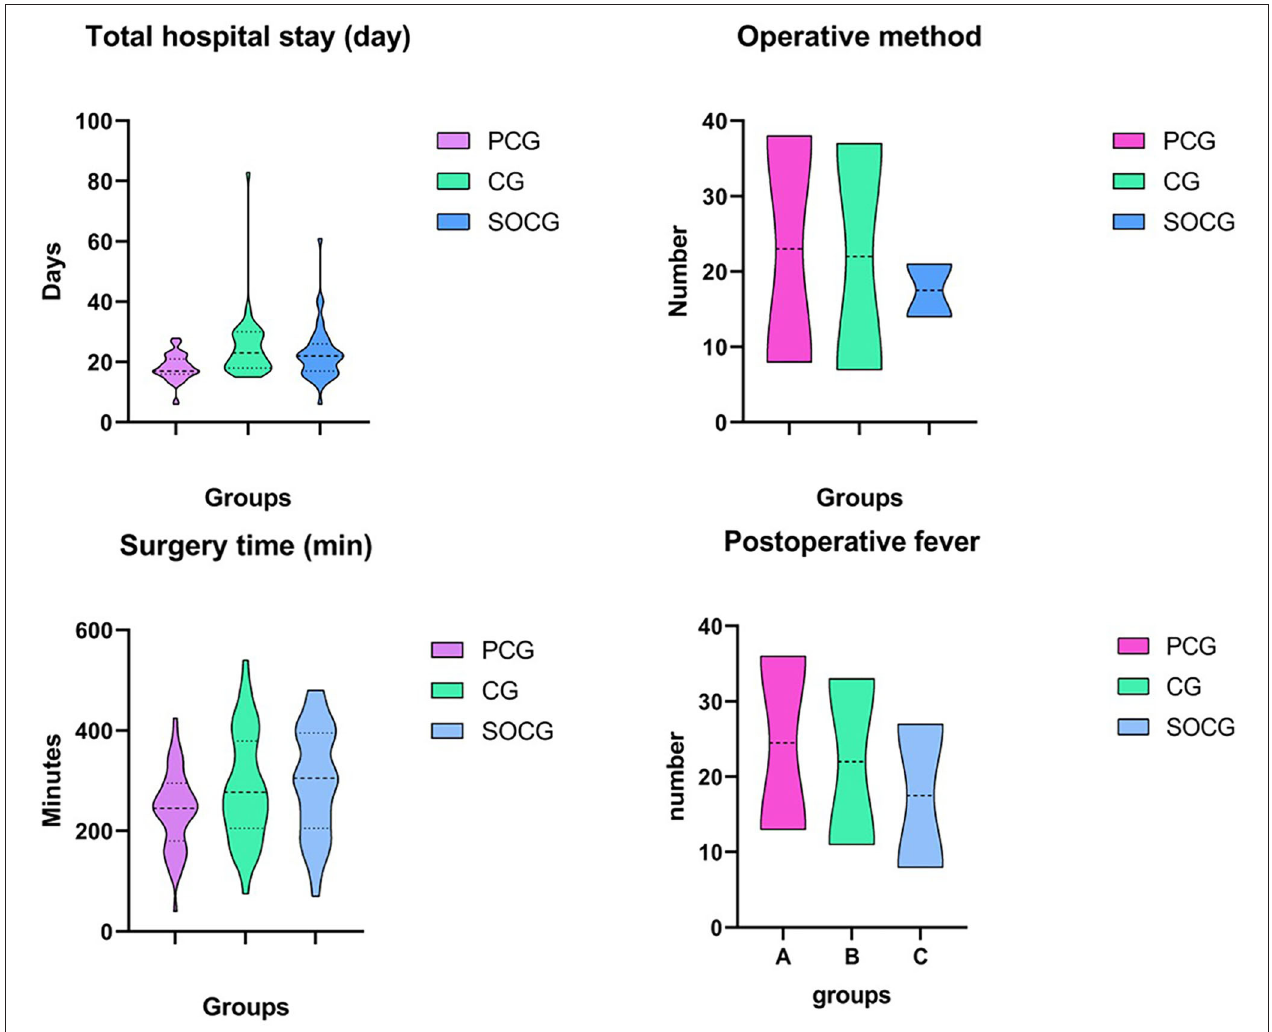
FIGURE 3 | The number of patients from outside the province decreased significantly ( p < 0.05). The total hospital stay during the epidemic was substantially more extended ( p < 0.05). Before the epidemic, our department used more open surgery while after the epidemic outbreak, we tended to choose laparoscopy ( p < 0.01), corresponding to the extended surgery time( P < 0.05). Patients had significantly less post-operative fever during the epidemic ( p < 0.001). PCG: August 20, 2019–January 19, 2020; CG: January 20, 2020–June 14, 2020; SOCG: June 15, 2020–October 10,